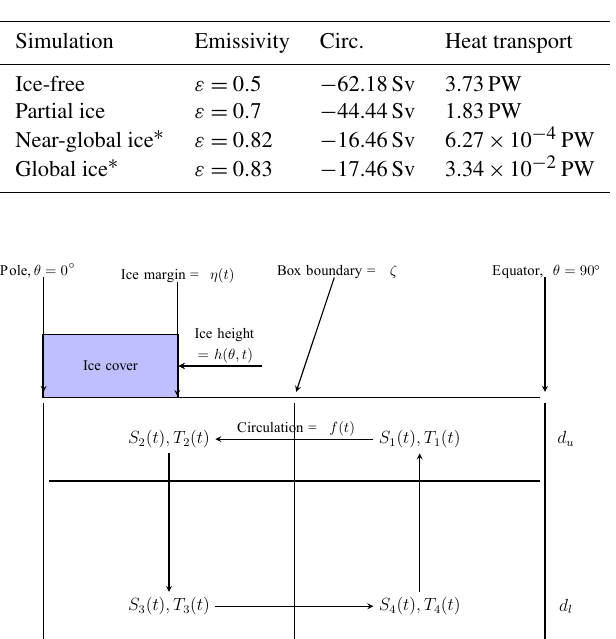
Table 1. Summary of results. Asterisk indicates simulations with insolation at 94% of present-day values. Negative circulation values indicate surface poleward flow.